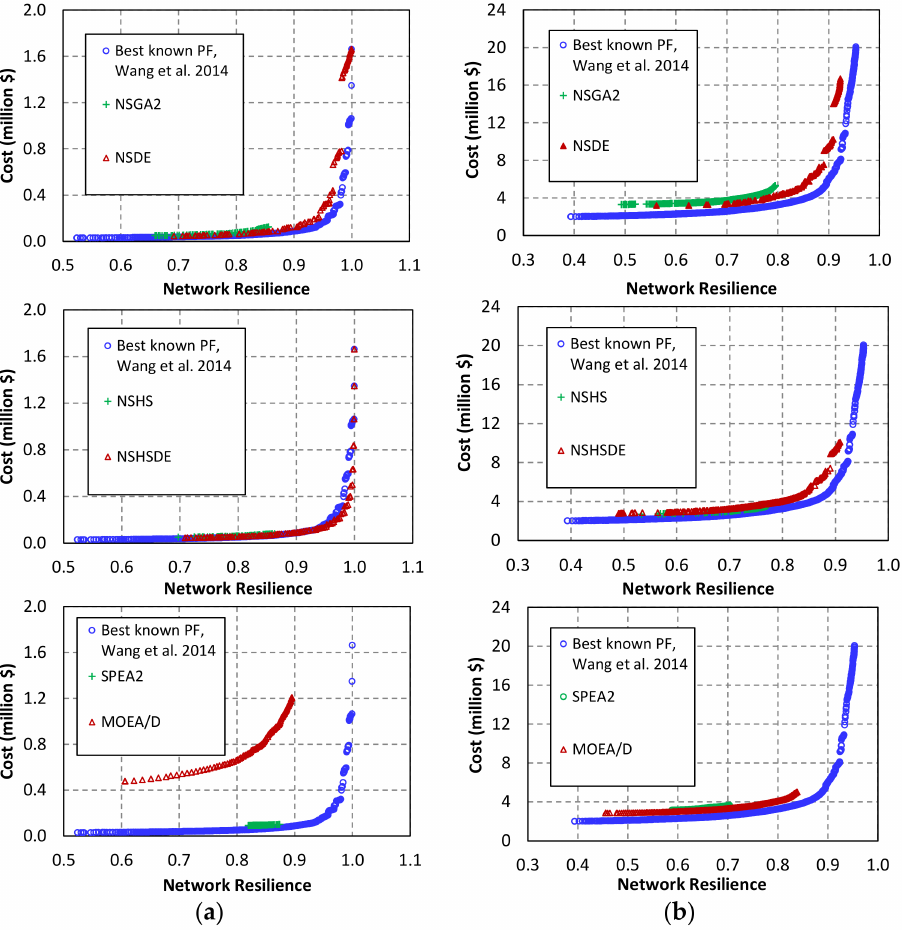
Figure 6. Pareto front (PF) of benchmark problems, ( a ) Fossolo network (FOS) problem; ( b ) Balerma network (BIN)